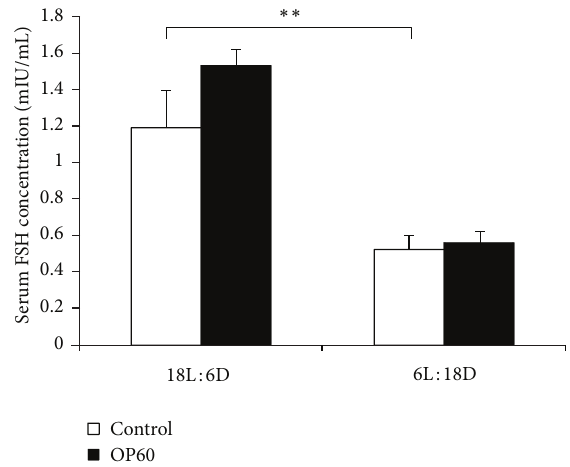
Figure 3: The effect of 4- tert -octylphenol treatment on FSH levels in the testes of 18L: 6D and 6L:18D bank voles. Values are expressed as mean ± SD. Asterisks indicate significant differences between control animals (control, 𝑛 = 6 /each group) and males exposed to OP for 60 days (OP60, 𝑛 = 6 /each group). Statistical significance: ∗∗ 𝑃 < 0.01